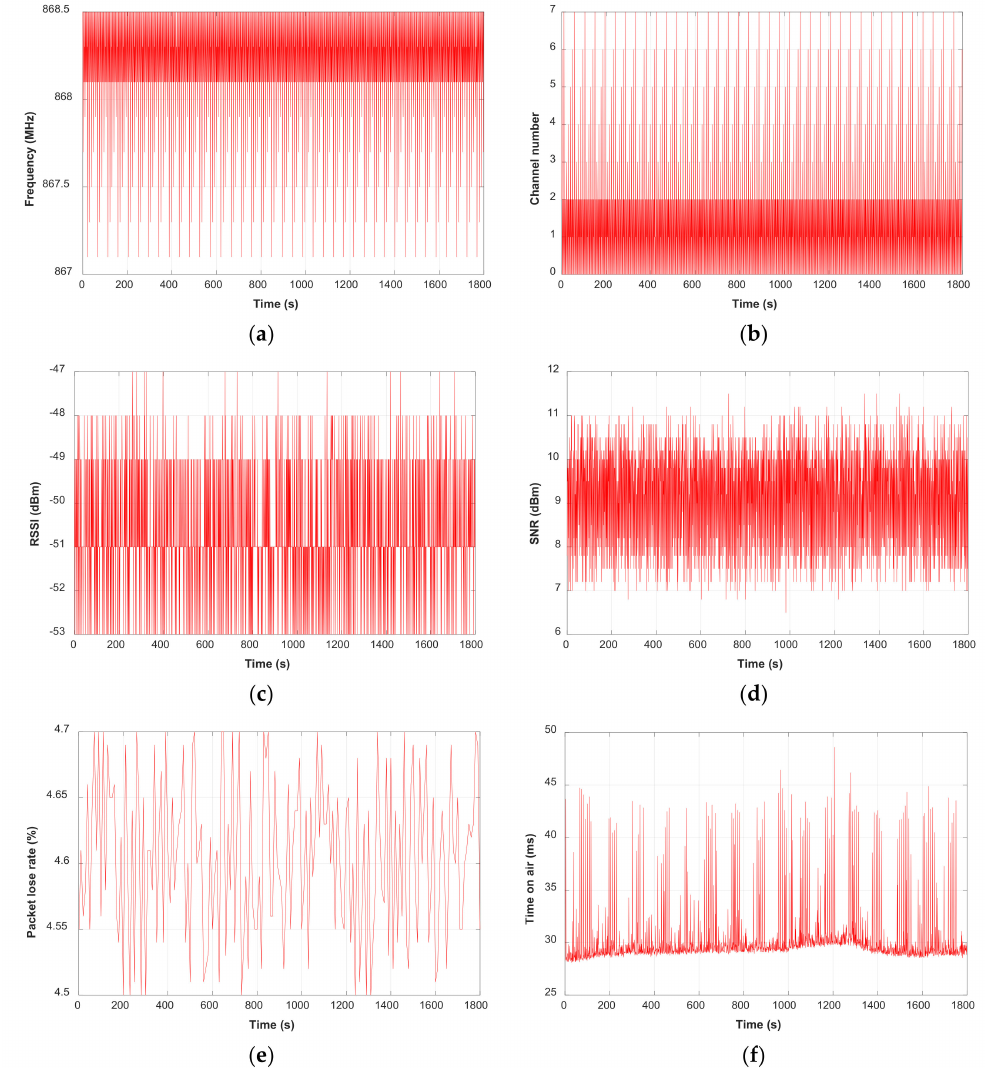
Figure 21. Measurements on the LoRa network: ( a ) frequency; ( b ) channel number; ( c ) RSSI; ( d ) SNR; ( e ) PLR; and ( f ) time on air.